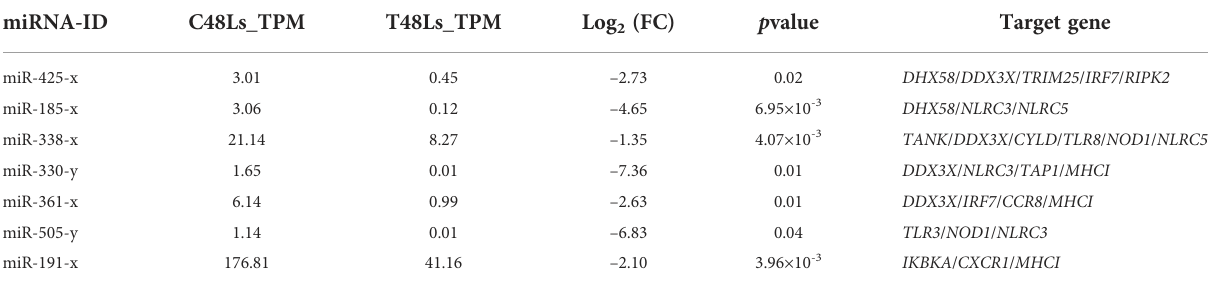
TABLE 4 Representative differentially expressed miRNAs (DEMs) in rainbow trout following infectious hematopoietic necrosis virus (IHNV) challenge. miRNA-ID C48Ls_TPM T48Ls_TPM Log 2 (FC) p value Target gene miR-425-x 3.01